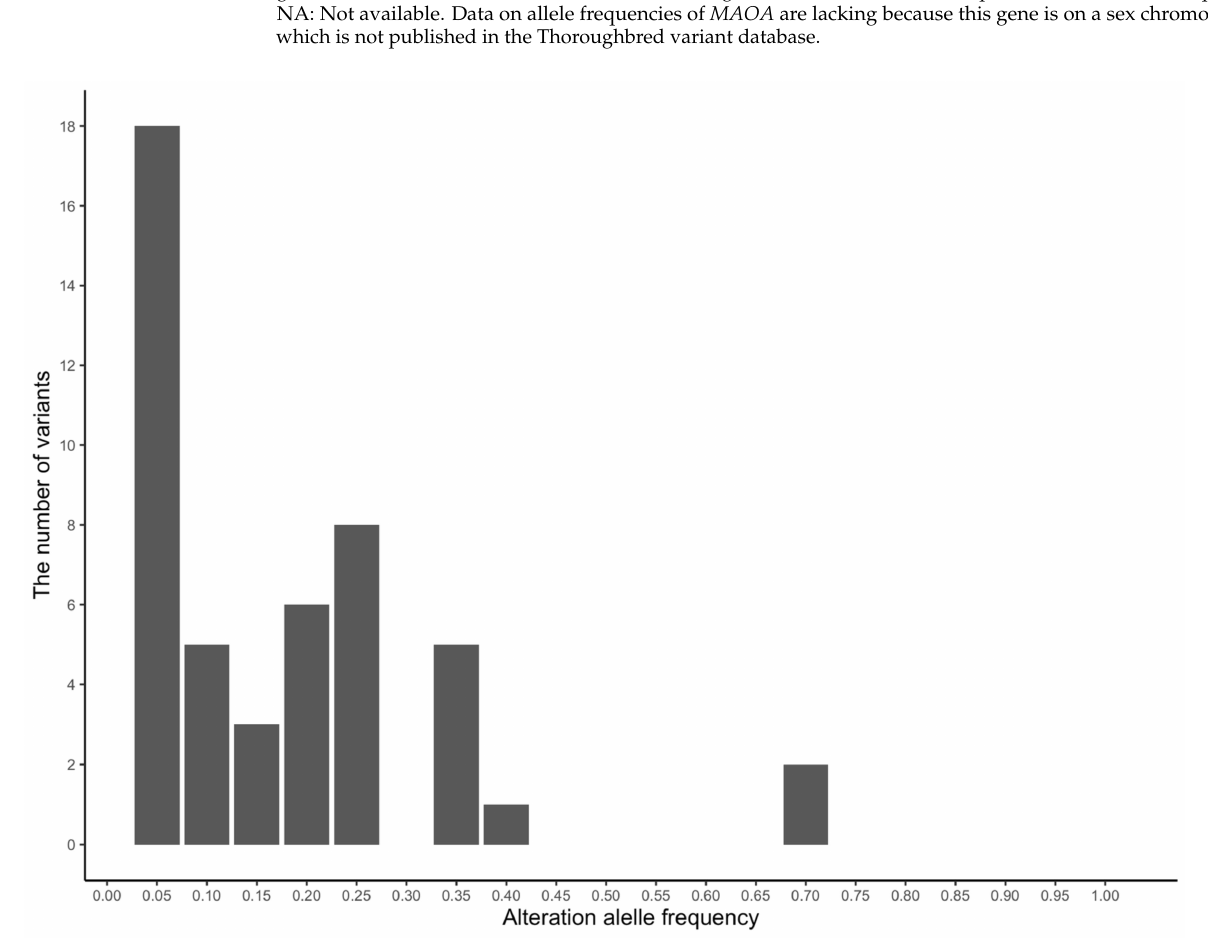
Figure 2. Distribution of alteration allele frequencies of the 18 most frequently identified horse personality-related genes. The histogram depicts the number of SNPs in each frequency hierarchy value. The total is 48 SNPs, and the maximum and minimum values of alteration allele frequency are 0.668 and 0.005,